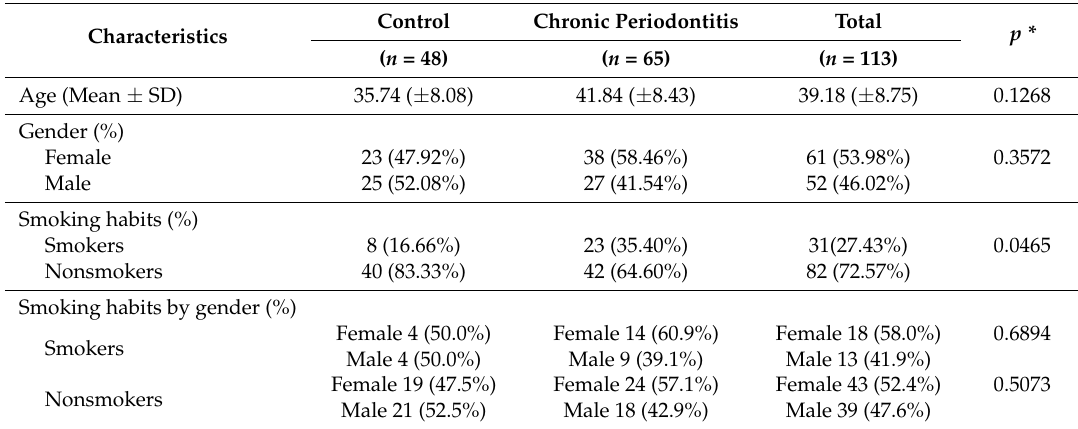
Table 1. Demographic characteristics of the study